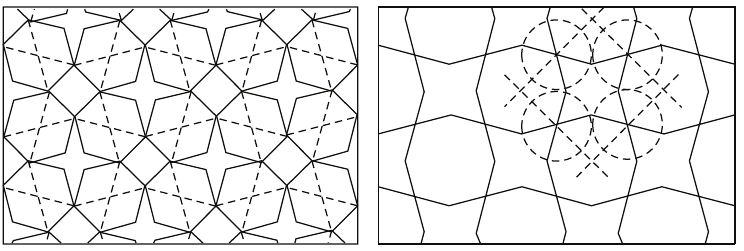
Figure 5: Arabic pattern development (Lewis F. Day).